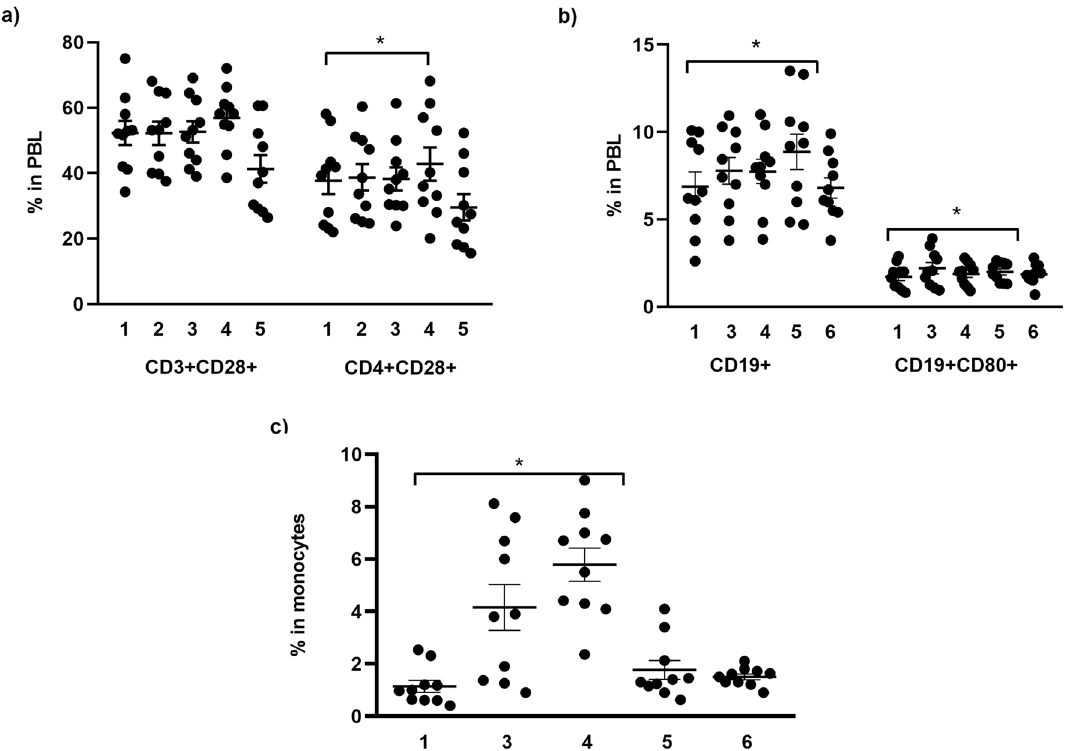
Figure 2. Percentage of ( a ) CD3 + CD28 + and CD4 + CD28 + T lymphocytes, ( b ) CD19 + and CD19 + CD80 + B lymphocytes, ( c ) CD14 + CD80 + monocytes in peripheral blood. The results are presented as individual values with mean ± standard error of the mean (SEM). Differences between values were compared using Wilcoxon signed-rank test and the results were considered statistically significant if p < 0.05. * p <